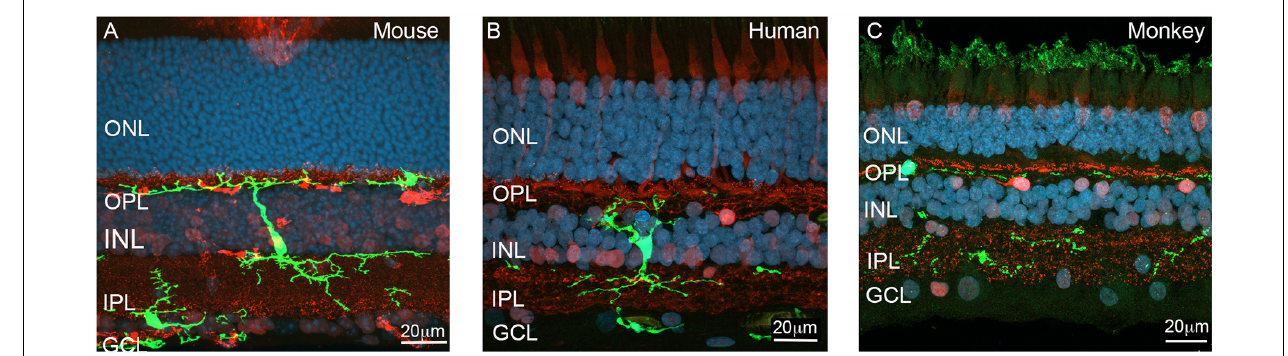
FIGURE 1 | Localization of microglia across the various layers of the retina. (A) Vertical section of the adult Cx3CR1 +/GFP mouse retina showing a reporter labeled microglial cell (green, EGFP) extending processes from the outer retina (OPL) to the inner retina (IPL). The section was also immunolabeled for the synapse (ribbon) marker, ribeye (red), while nuclei were visualized with bisbenzimide (blue). A second microglia cell (green) is located within the (GCL). (B) Vertical section of the human immunolabeled for the microglial marker, IbA1 (green) and calretinin (red). Nuclei are labeled with bisbenzimide (blue). The microglial cell is a large cell that extends processes into both the inner and outer retina where is contacts synapses. (C) Vertical section of monkey retina immunolabeled for microglia (IbA1, green) and a combination of the synapse marker, ribeye and the neuronal marker calbindin (red). Abbreviations: ONL, outer nuclear layer; OPL, outer plexiform layer; INL, inner nuclear layer; IPL, inner plexiform layer; GCL, ganglion cell layer. Scale 20 µ